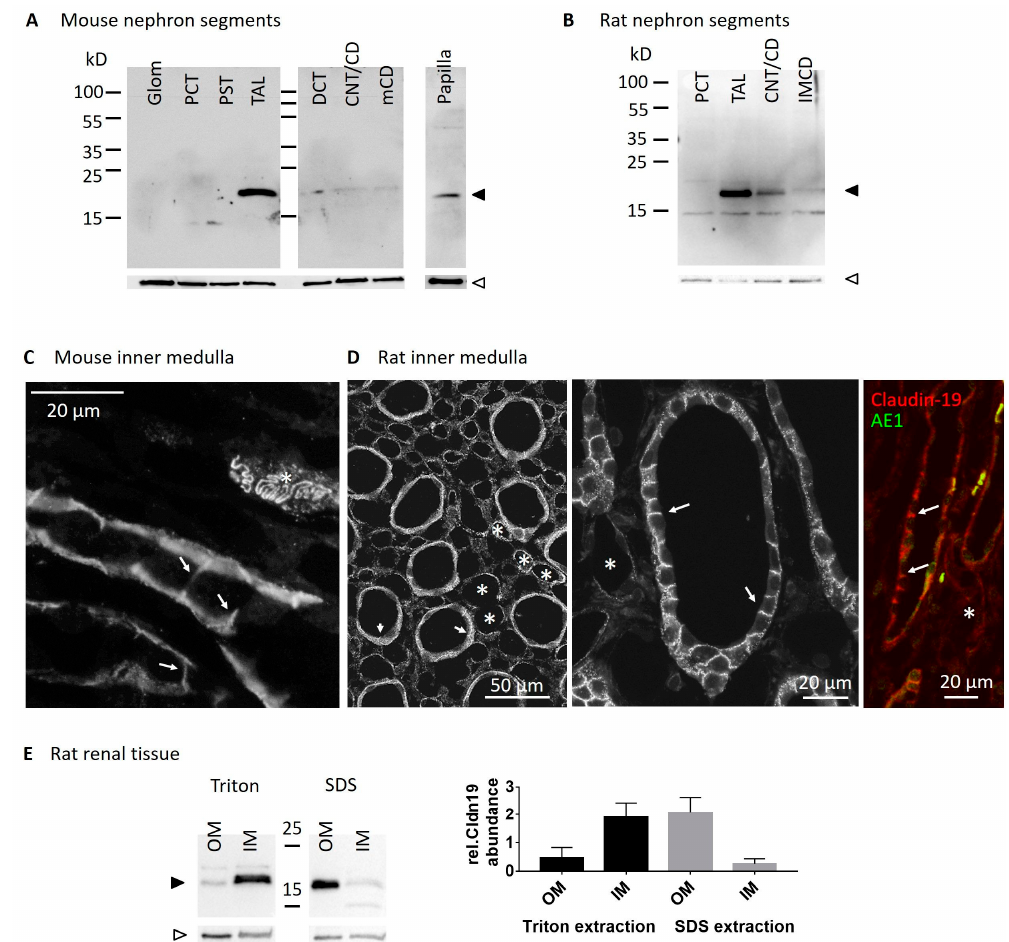
Figure 1. Claudin-19 in rodent kidney tissue. ( A ) Western blot of mouse kidney segments: glomeruli (Glom), proximal convoluted tubule (PCT), proximal straight tubule (PST), thick ascending limb (TAL), distal convoluted tubule (DCT), connecting tubule / cortical CD (CNT / CD), medullary CD (mCD), and papilla. Upper part: claudin-19 (black arrowhead), lower part: β -actin (white arrowhead). ( B ) Western blot of rat kidney segments: proximal convoluted tubule (PCT), thick ascending limb (TAL), connecting tubule and cortical CD (CNT / CD) and inner medullary collecting duct (IMCD). Claudin-19 and β -actin indicated as in A. Immunofluorescence of claudin-19 in mouse ( C ) and rat ( D ) inner medulla, arrows indicate claudin-19 TJ expression in IMCD, asterisks indicate thin limbs. AE1 (green) costaining in claudin-19 (red) positive IMCD in rat inner medulla. ( E ) Western blot of rat kidney tissue: Triton and SDS solubilized protein extracts of Cortex, outer medulla (OM) and inner medulla (IM), claudin-19 and β -actin indicated as in A. Summary of n = 2 independent extraction experiments showing Triton solubilization mainly in IM and SDS solubilization mainly in